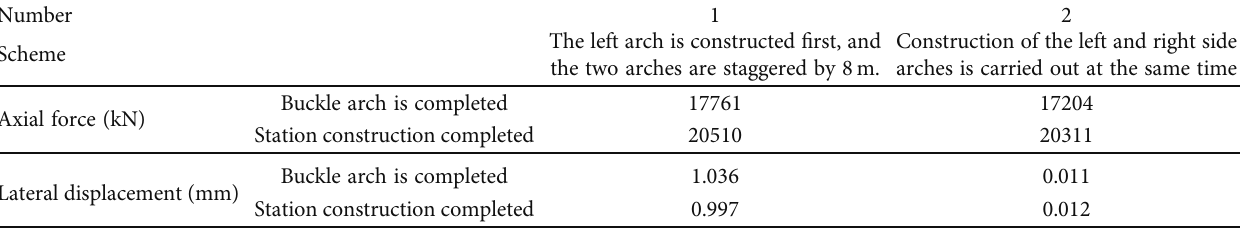
Table 4: The force and displacement of the central column with di ff erent arching sequences.